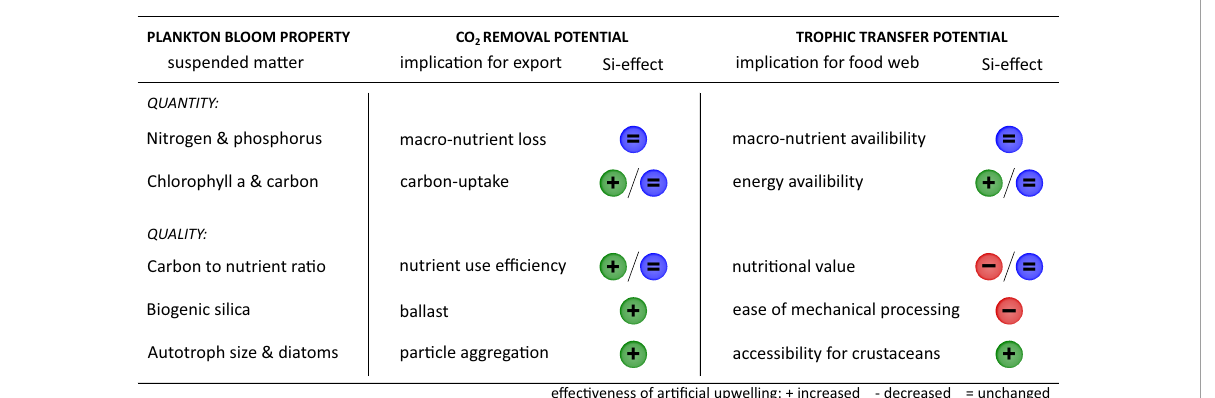
FIGURE 6 Possible consequences of varying Si:N in deep water for the effectiveness of arti fi cial upwelling. Our fi ndings for suspended matter are conceptually related to trophic transfer towards fi sheries and carbon removal via the biological pump. Signs indicate increased (+), decreased ( − ) or unchanged (=) effectiveness. Two signs are given in case of a temporal pattern in the Si-effect: left for initial ( fi rst 2 weeks) and right for longer-term (following 2 weeks). This overview is limited to the simpli fi ed, ‘ classical ’ model of pelagic